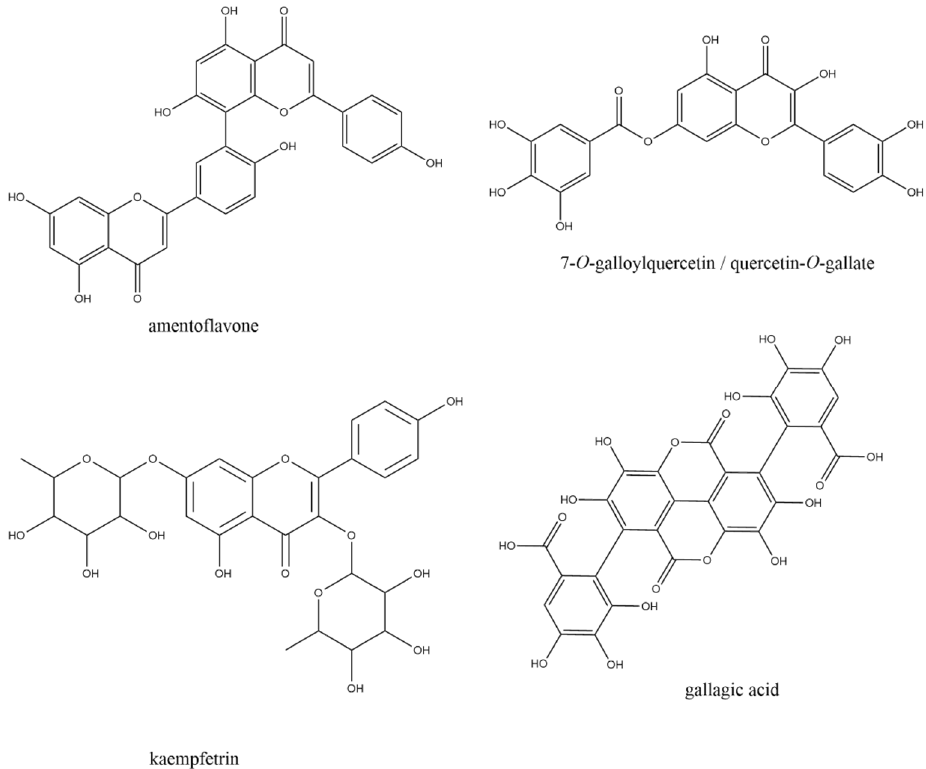
Figure 1. Schematic representation of the four plant metabolites that presented the most promising interaction parameters with SARS-CoV-2 drug targets, through molecular docking.